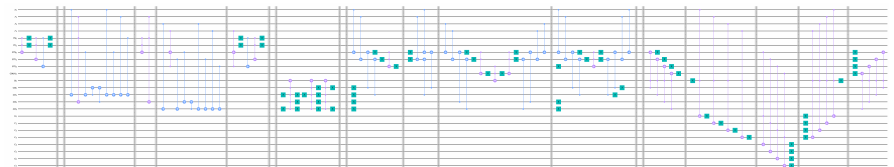
Figure 21. Quantum implementation of the 4 × 4 M